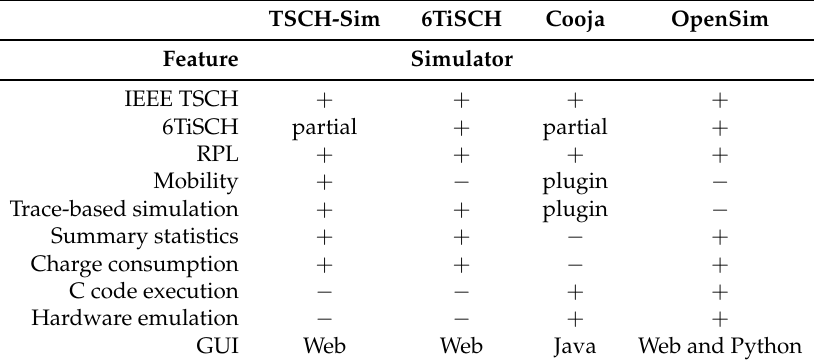
Table 1. TSCH simulator comparison.